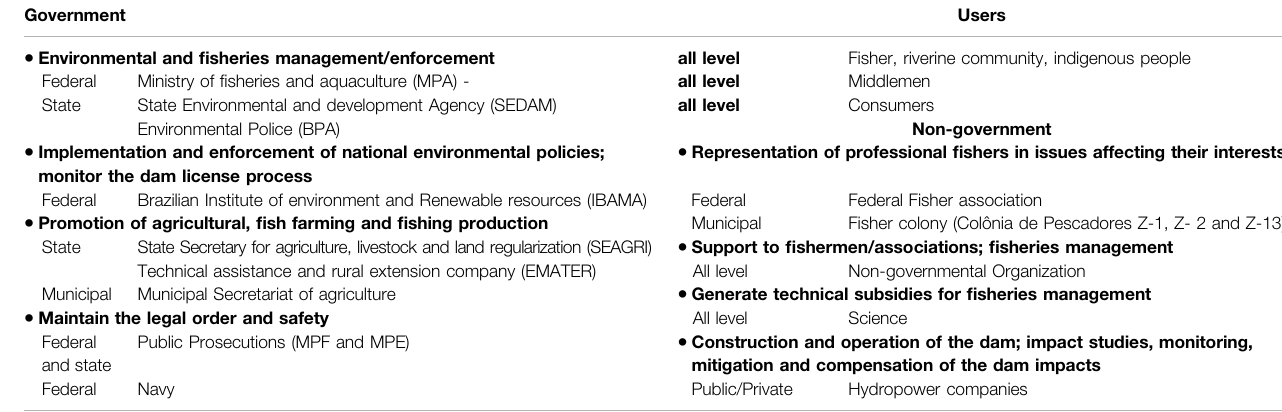
TABLE 2 | Organizations by groups of stakeholders and geographic scale (Federal, State, municipal) of the Madeira Fisheries System and their main function. Government